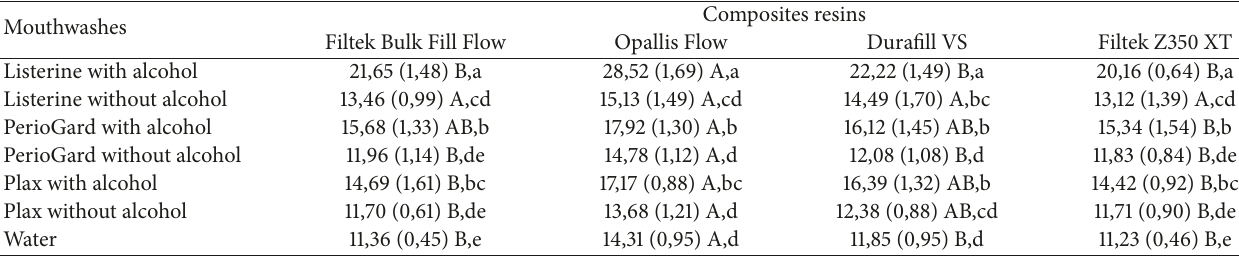
Table 3: Average ( ± SD) of sorption ( 𝜇 g/mm 3 ) according to composite resin and mouthwashes ( 𝑛 = 6 ).